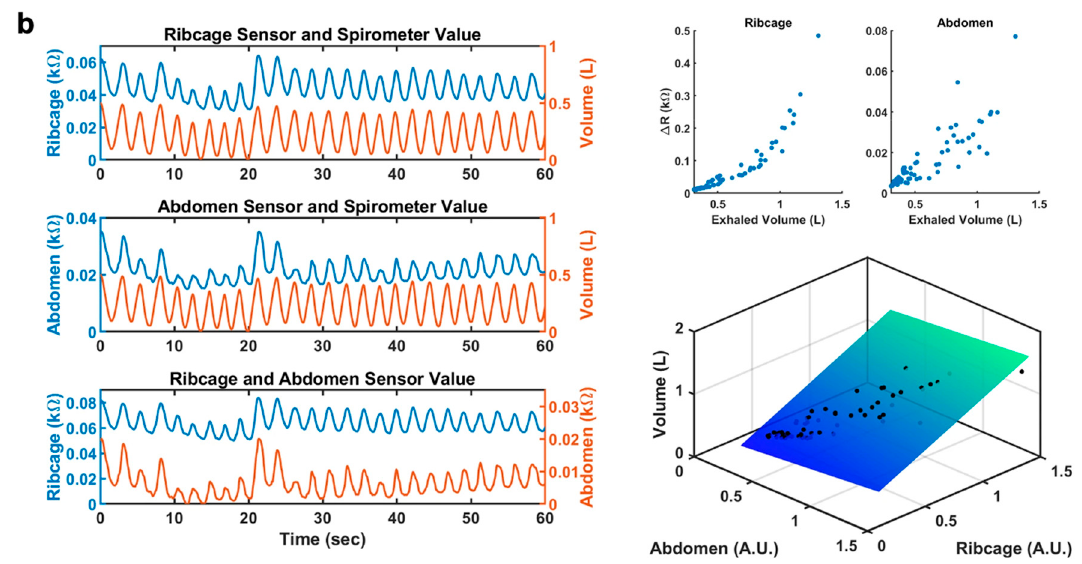
Figure 20. ( a ) Demonstration of sensor placement for ribcage and abdomen along with attachment setup. ( b ) Representative signals from ribcage and abdomen plotted with simultaneous respiration volume along with scatterplots for each [6]. Adapted and reproduced with permission as licensed under the Creative Commons Attribution 4.0 International License.